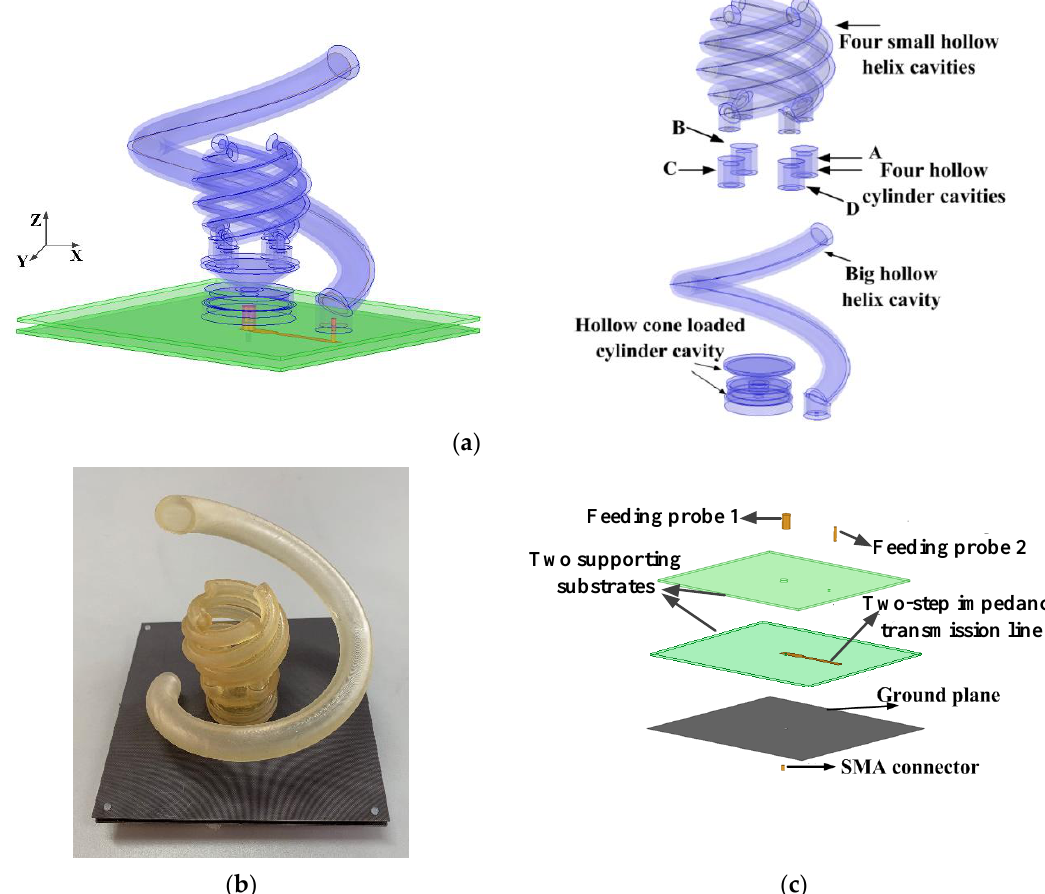
Figure 1. The liquid-metal-based reconfigurable antenna: ( a ) The three-dimensional structure; ( b ) A photograph of the fabricated prototype; ( c ) An exploded view of the structure.